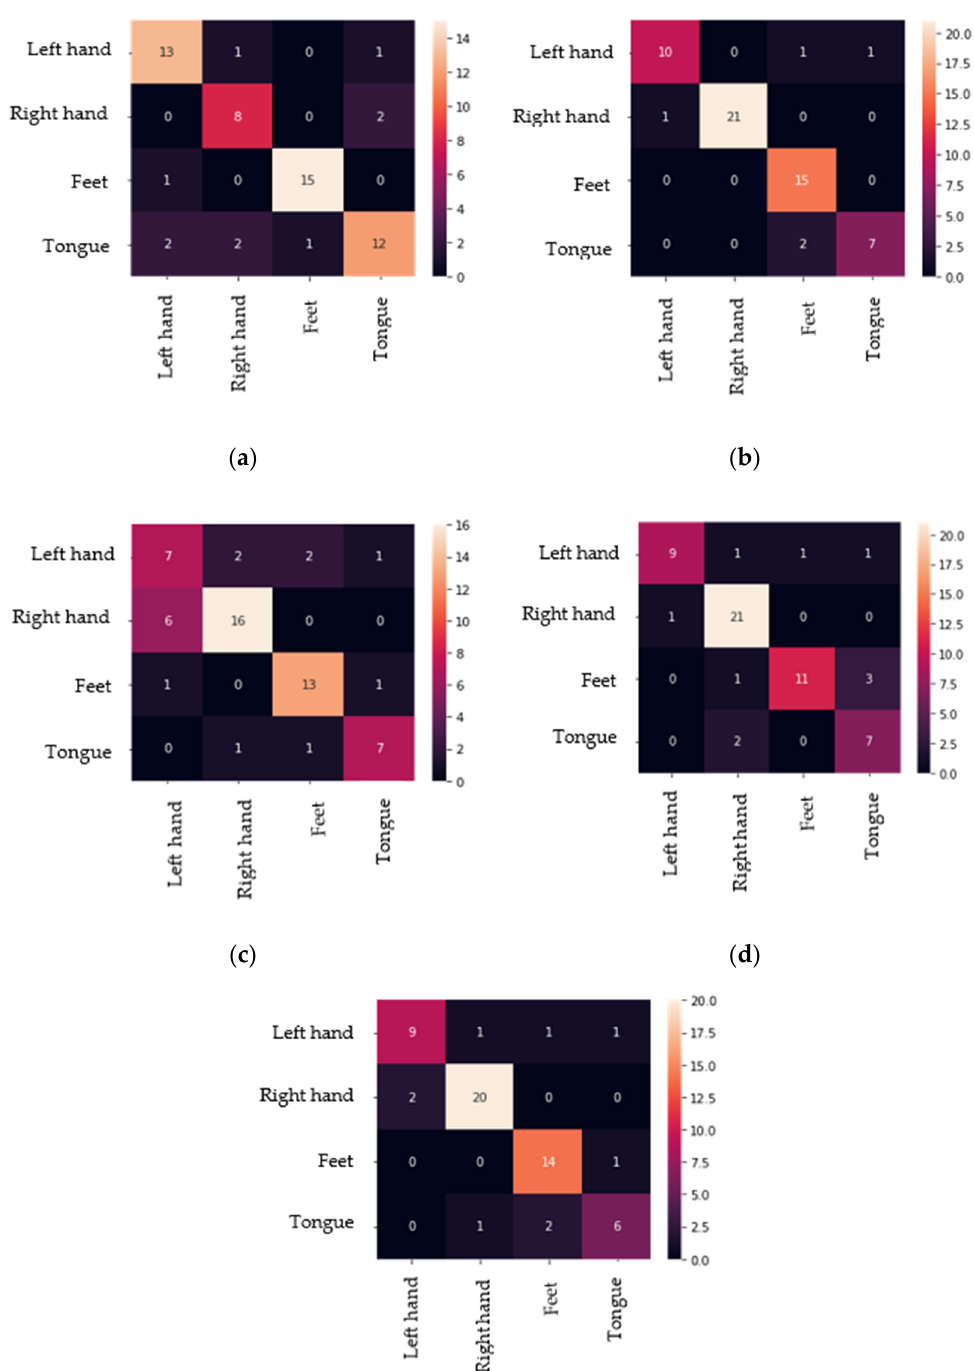
Figure 10. Confusion matrices of classification accuracy for the proposed methods based on ( a ) ANN, ( b ) CNN1, ( c ) CNN2, ( d ) Merged CNN1 with CNN2, ( e ) Modified merged CNN1 with CNN2 model (Subject 3).